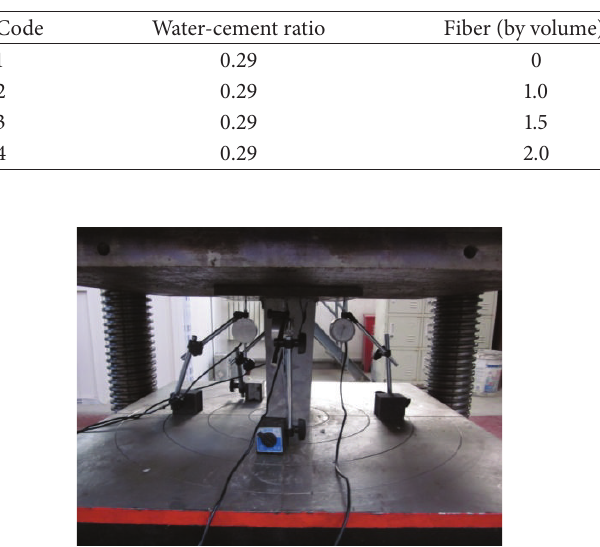
Figure 1: Test loading device.